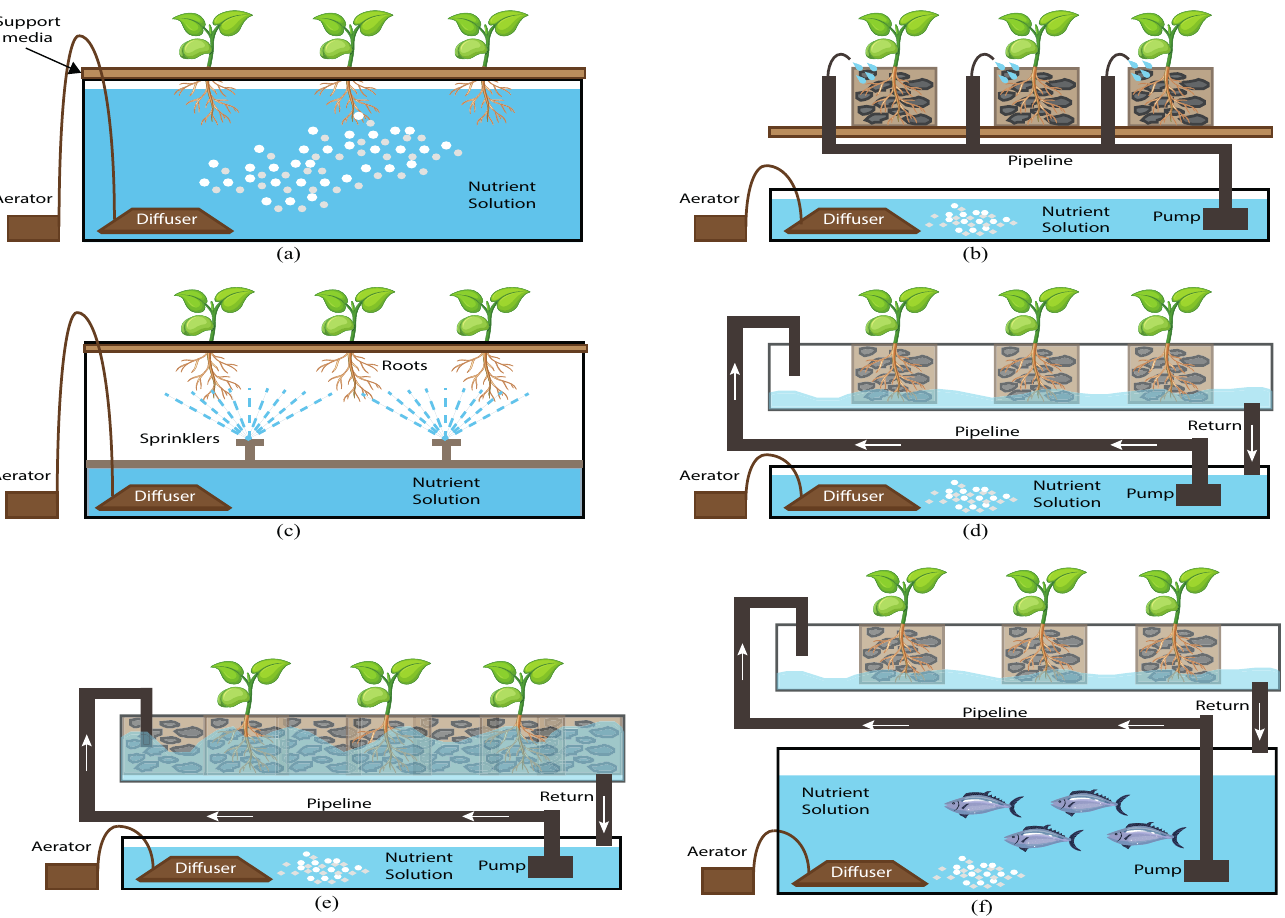
Figure 1. Different types of hydroponic systems. ( a ) Deep Water Culture. ( b ) Drip System. ( c ) Aero- ponics. ( d ) Nutrien Film Technique (NFT). ( e ) Ebb and flow. ( f )